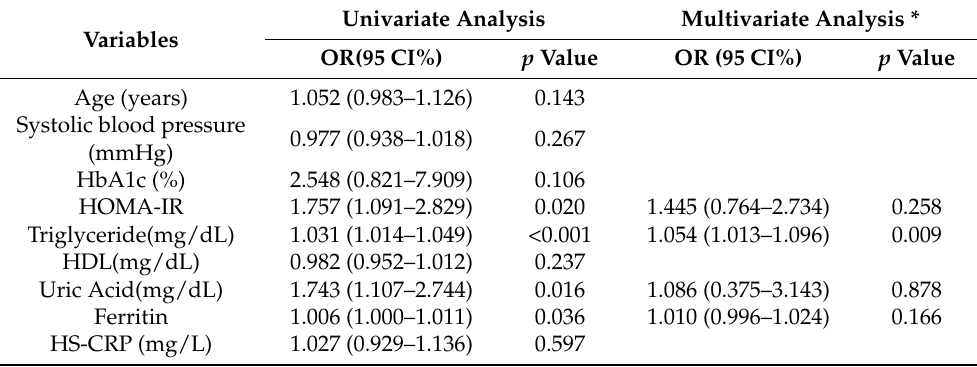
Table 4. Univariate and multivariate analysis of variables associated with risk of liver steatosis with FLI >